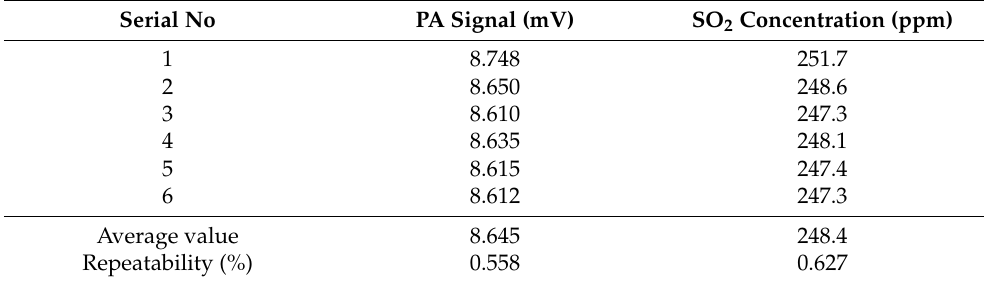
Table 2. Repeatability of the detection system. Serial No PA Signal (mV) SO 2 Concentration